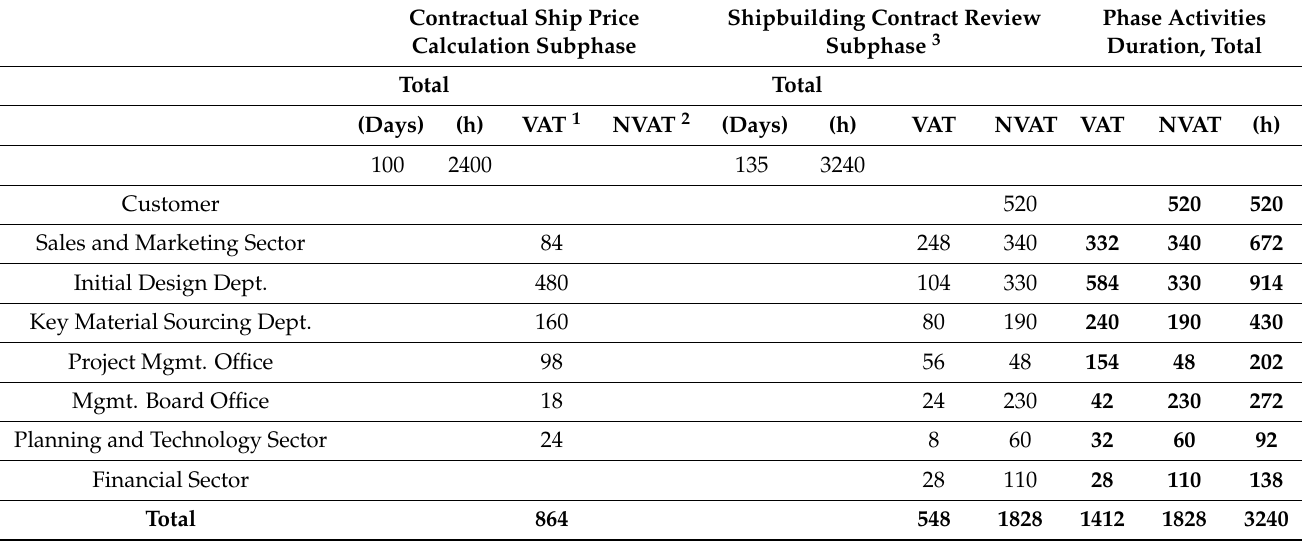
Table A9. The average durations of the contracting phase activities—the future state.